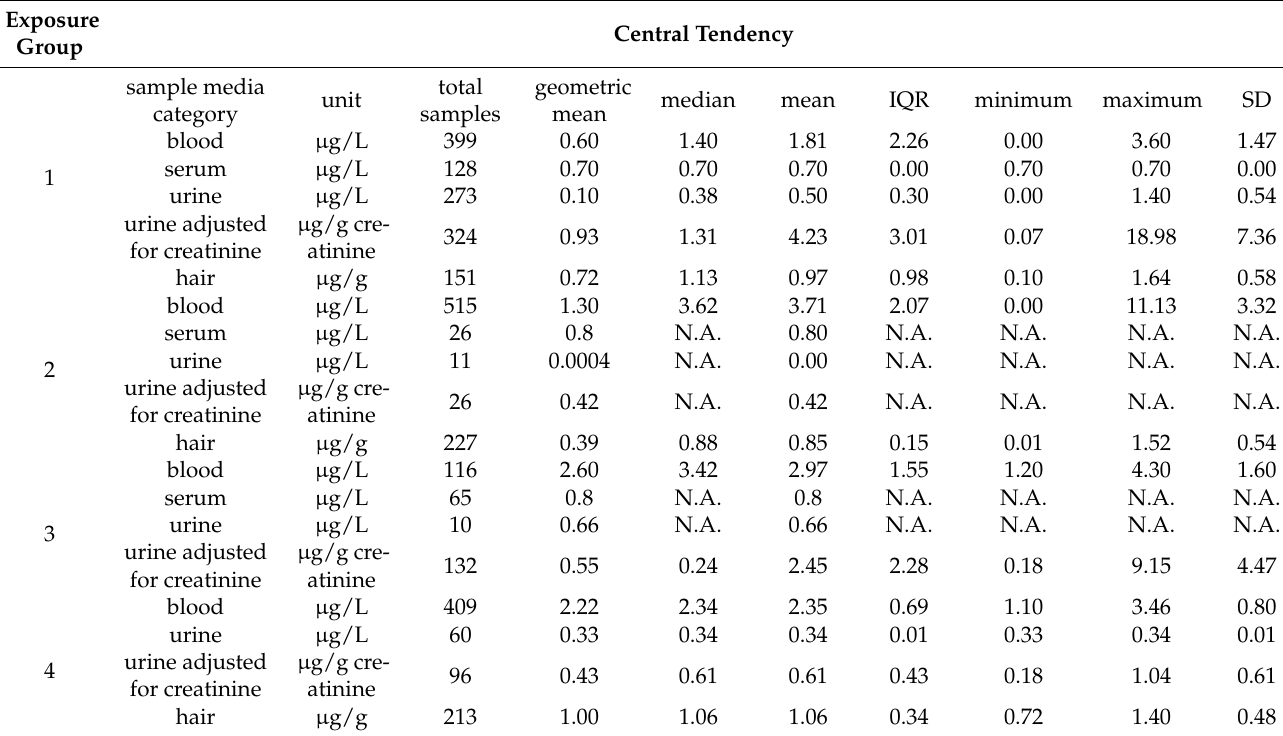
Table 4. Central Tendency Mercury Values of Biomarker Samples from Populations Involved with